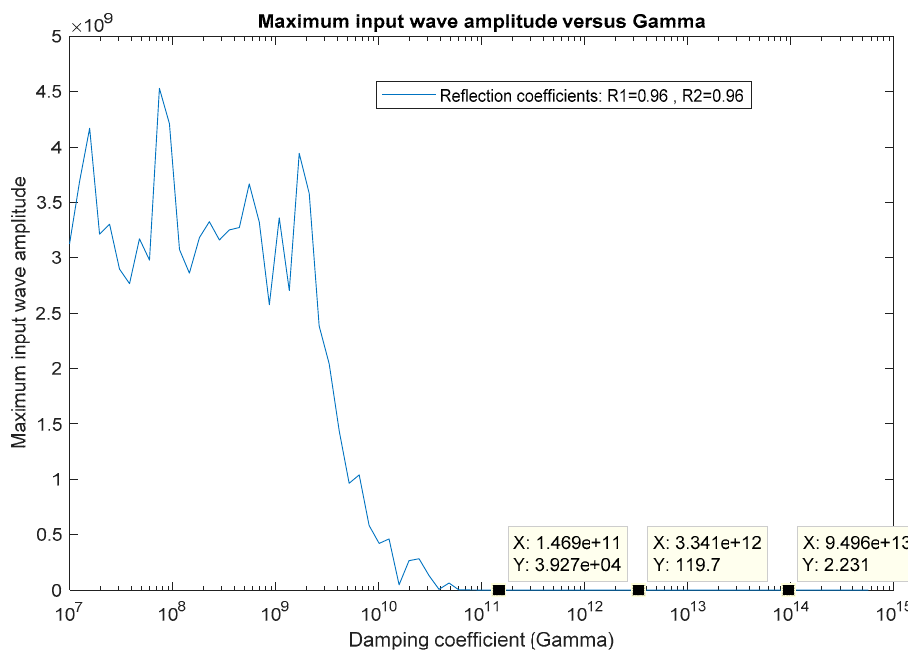
Figure 16. Maximum input wave amplitude at x = 5.73 µ m versus the damping coe ffi cient gamma ( γ ).